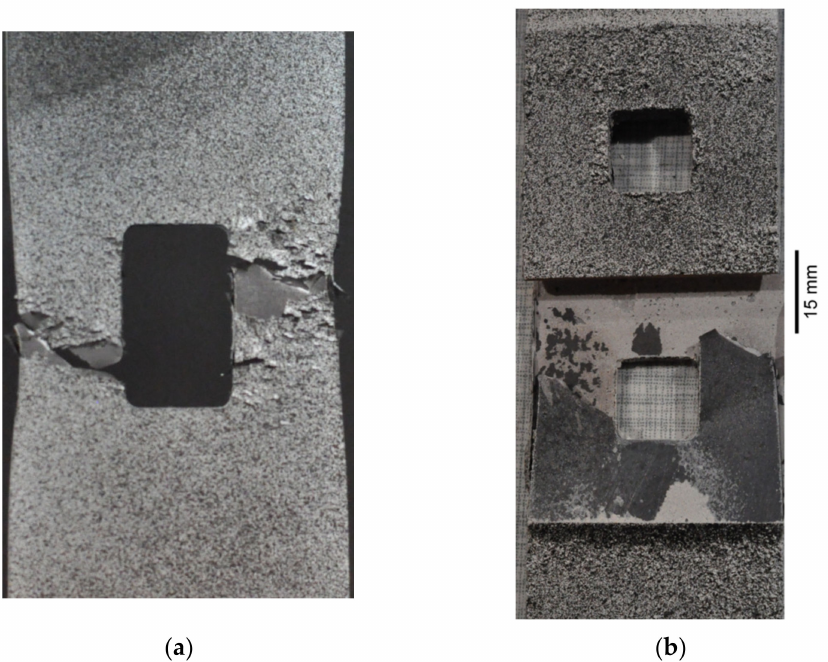
Figure 20. Failure form of notched samples: ( a ) no. 16 without overlays; ( b ) no. 18 with composite Hexcel TVR 380 [+45 ◦ / − 45 ◦ ] 4 overlays. Samples were covered by speckle patterns for DIC